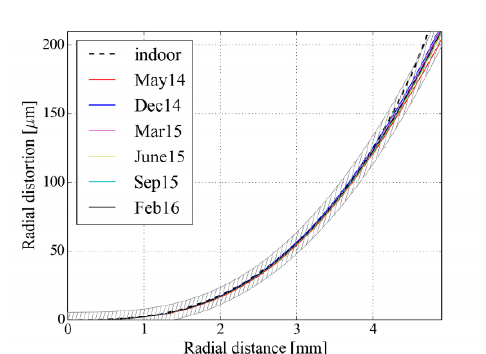
Figure 3. Radial distortion curves. The grey zone indicates the confidence level of ± 3σ.